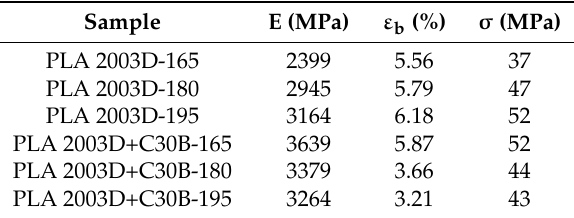
Table 6. Elastic modulus (E), elongation at break ( ε b ), and tensile strength ( σ ) of PLA 2003D and PLA 2003D+C30B specimens printed at different temperatures (standard deviation ± 5–10%).